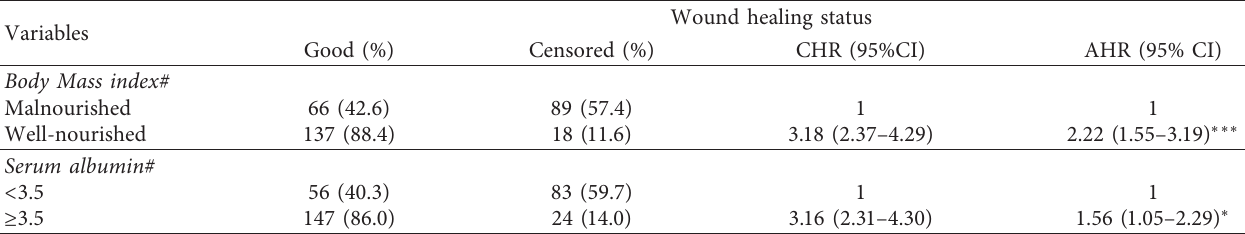
Table 4: Predictors of wound healing among adult patients undergoing abdominal surgery at Bahir Dar City Public Hospitals, Northwest Ethiopia, 2019 ( N � 310).